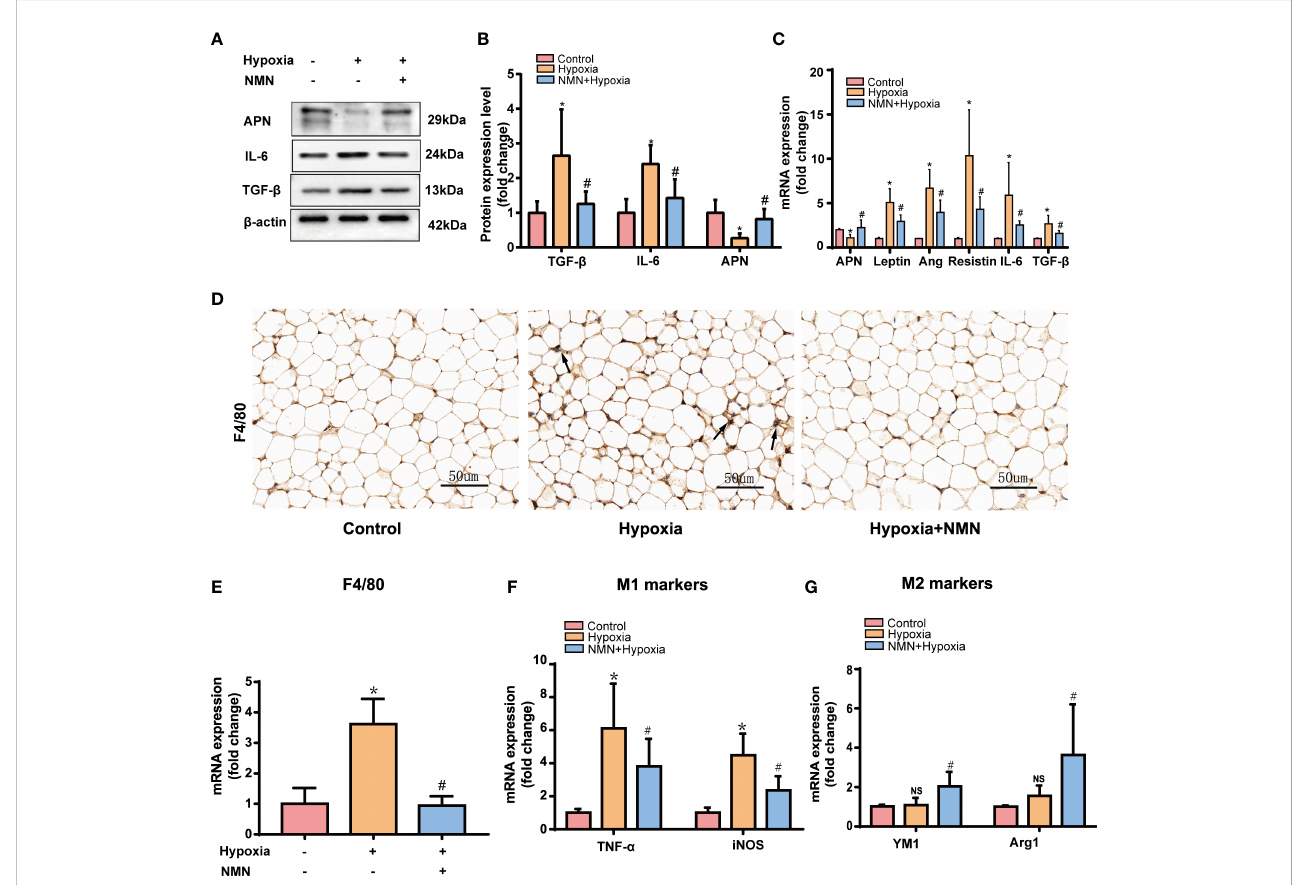
FIGURE 2 NMN alleviates dysregulated adipokines secretion and macrophage in fi ltration in the eWAT of hypoxia induced mice. (A, B) The relative protein levels of APN, TGF b , and IL-6 normalized to b -actin in eWAT (n = 5). (C) The relative mRNA levels of APN, leptin, ang, resistin, IL-6, and TGF- b normalized to b -actin in eWAT (n = 6). (D) Representative images of macrophage marker F4/80 in eWAT as re fl ected by the IHC staining (400 × magni fi cation, scale bar = 50 m m). (E) The relative mRNA levels of F4/80 in eWAT (n = 6). (F, G) The relative mRNA levels of genes encoding TNF a , iNOS, Arg1 and Ym1 in eWAT (n = 6). * P < 0.05 versus control group, # P < 0.05 versus hypoxia